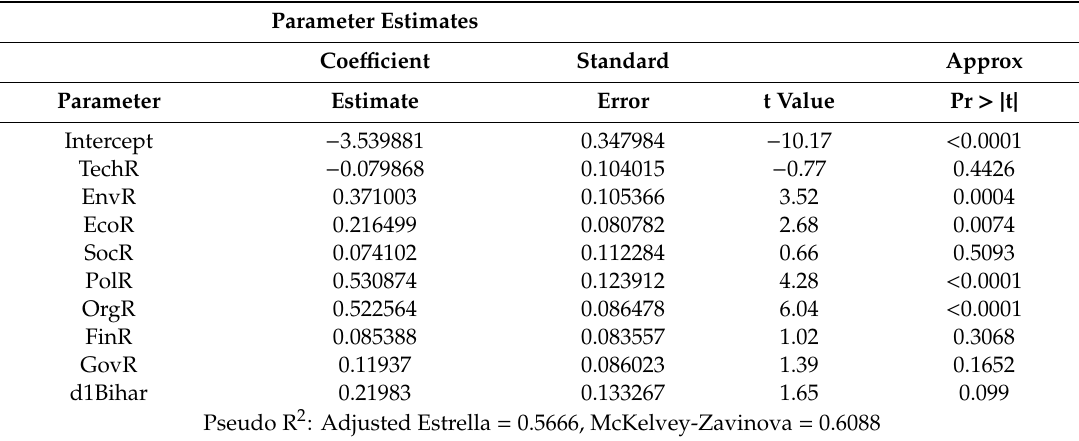
Table 13. Ordered probit regression results—rationalities and equity